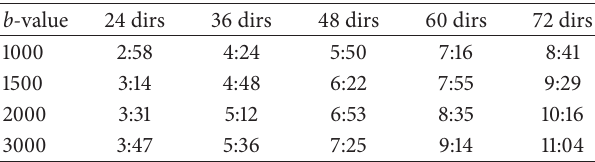
Table 3: Approximate whole brain measurement times for a single repetition in (min:sec) with the acquired